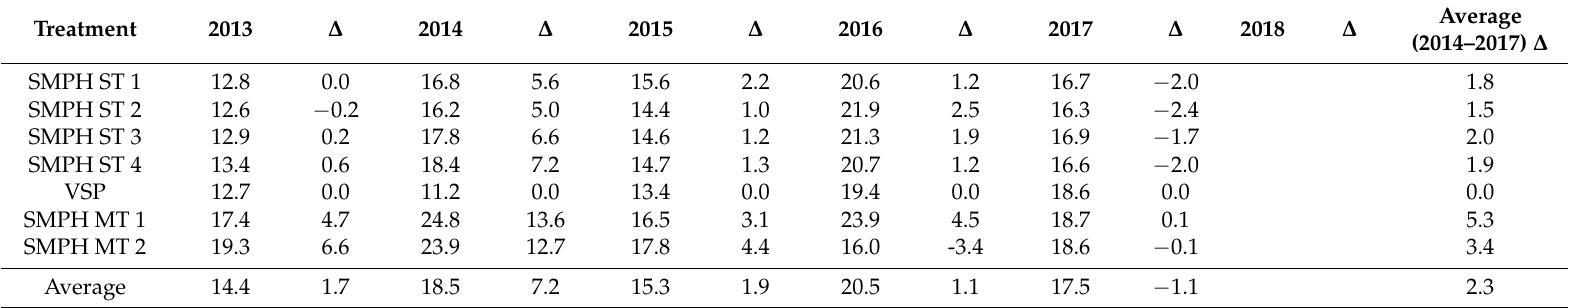
Table 3. Calculated total soluble solids (brix) on the day of the year (DOY) for reaching 5% disease severity between 2013 and 2018 as well as deviations ( ∆ ) between the total soluble on the day of the year for reaching 5% disease severity in a specific year and the total soluble on the days of the year for reaching 5% disease severity in the standard treatment, VSP, in that year. Average (2014–2017) deviations of different treatments are depicted. Since in 2018 5% disease severity were not reached in all treatments, calculated data were not